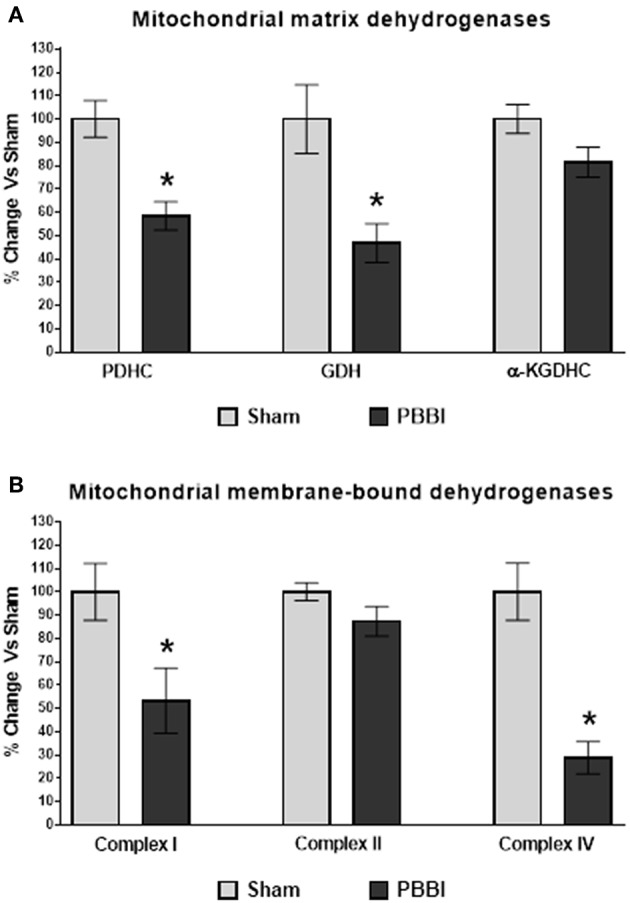
Decreased dehydrogenase activities following PBBI. (A) At 24 h post-PBBI, PDHC (42%, p < 0.05) and GDH (53%, p < 0.05) enzyme activities were significantly decreased; whereas no significant differences were noted in α-KGDHC activity between groups. (B) The Complex I (47%, *p < 0.05) and Complex IV (81%, *p < 0.05) enzyme activities of ETC were significantly impaired in the PBBI group; whereas no change in Complex II enzyme activity was observed between experimental groups. Bars represent group means ± SEM (n = 5 animals / group). *p < 0.05 compared to sham injured group (unpaired t-test).